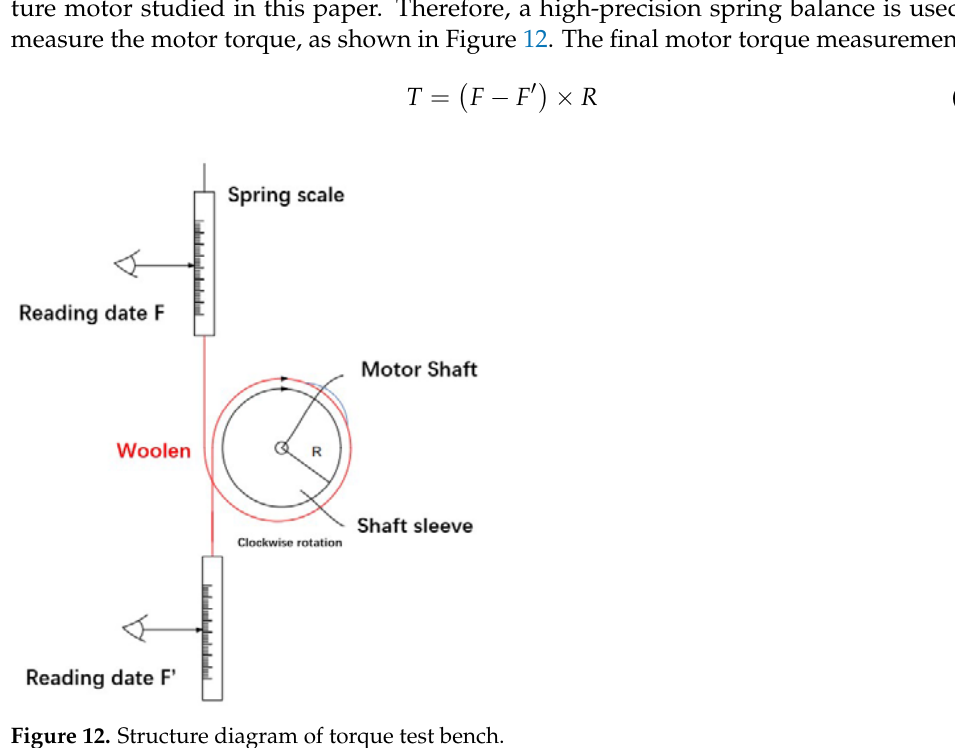
Figure 13. Micro stepper motor torque test bench. Table 3. Stepper motor holding torque test values. Test Current I / A